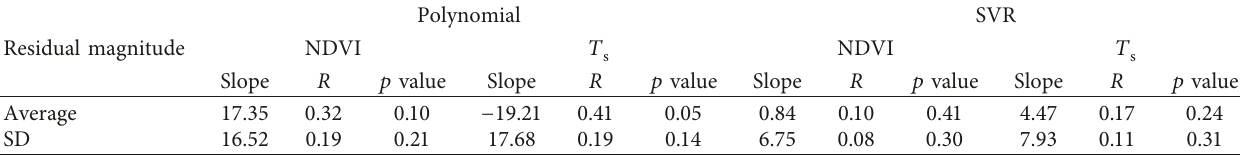
Table 4: Correlation analysis between the independent variables and residual